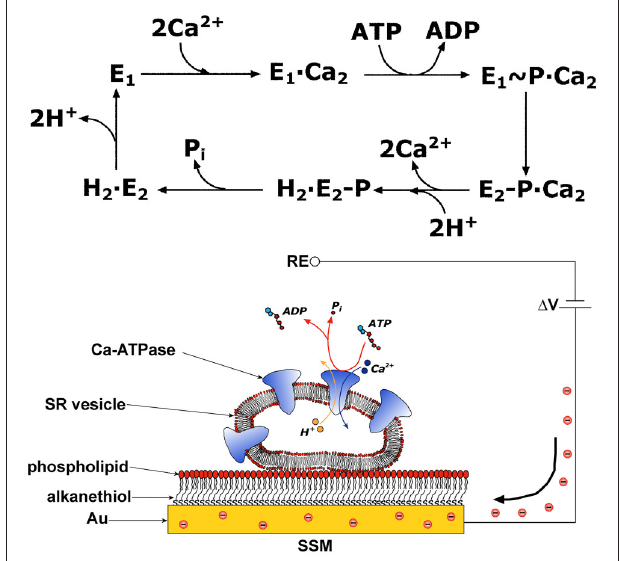
FIGURE 1 | Upper Panel: Schematic diagram of sequential reactions in the transport cycle of SERCA. Lower Panel : SR vesicle adsorbed on a SSM and subjected to an ATP concentration jump (not drawn to scale). If the ATP jump induces net charge displacement, a compensating current flows along the external circuit (the red spheres represent electrons) to keep constant the potential difference 1 V applied across the whole system. RE is the reference electrode. Reprinted from Tadini-Buoninsegni et al. (2008a) with permission from Elsevier.